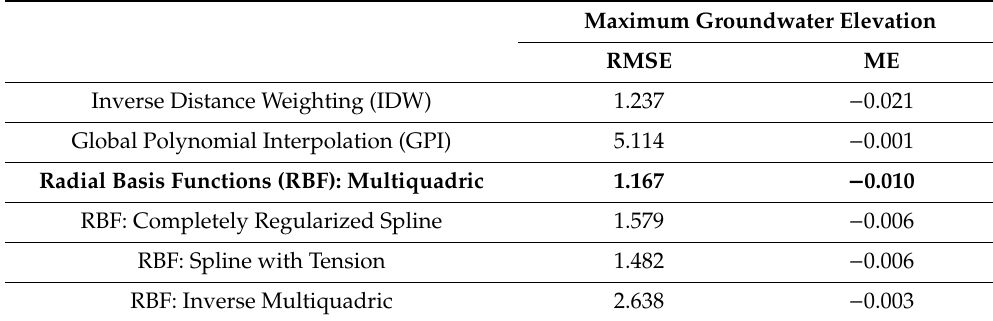
Table 2. Comparison of various tested deterministic interpolation methods.